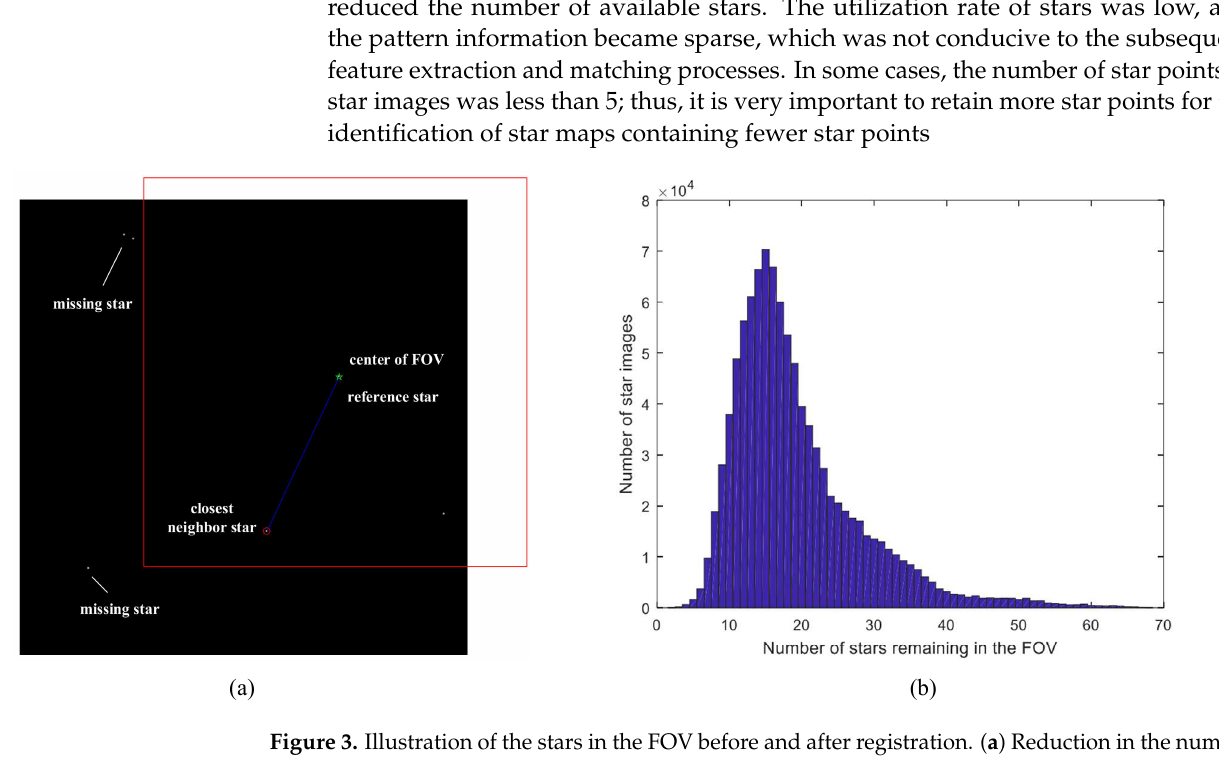
Figure 3. Illustration of the stars in the FOV before and after registration. ( a ) Reduction in the num- ber of stars in the FOV after registration. ( b ) Number of stars remaining in the FOV.